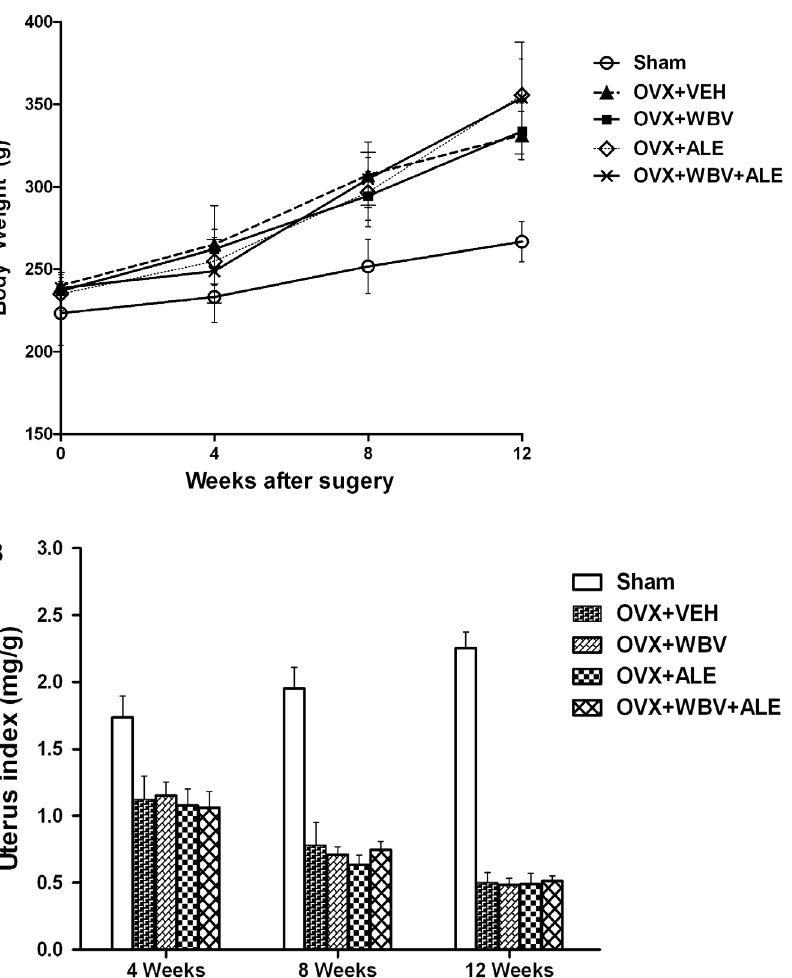
Figure 2. The body weight and uterus index of rats are provided in Fig.2. Body weight (A) and uterus index (B) changes measured using an electronic scale. *P , 0.01 compared with the sham